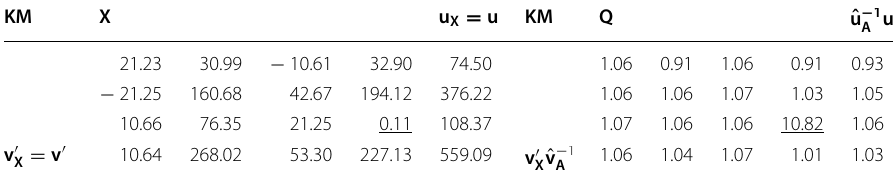
With the same location of underlined matrix elements as in Table 18